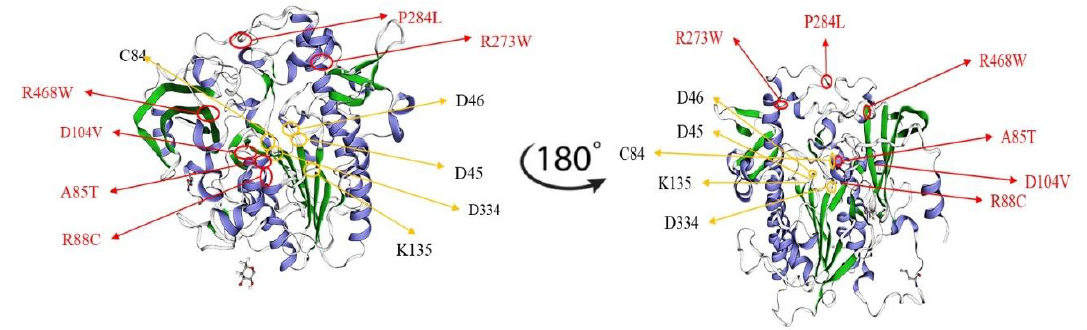
Figure 5. 3D structure analysis by simulating six missense residues, i.e., c.253G>A (p.A85T), c.262C>T (p.R88C), c.311A > T (p.D104V), c.817C > T (p.R273W), c.851C > T (p.P284L), and c.1402C > T (p.R88C), c.311A>T (p.D104V), c.817C>T (p.R273W), c.851C>T (p.P284L), and c.1402C>T (p.R468W),